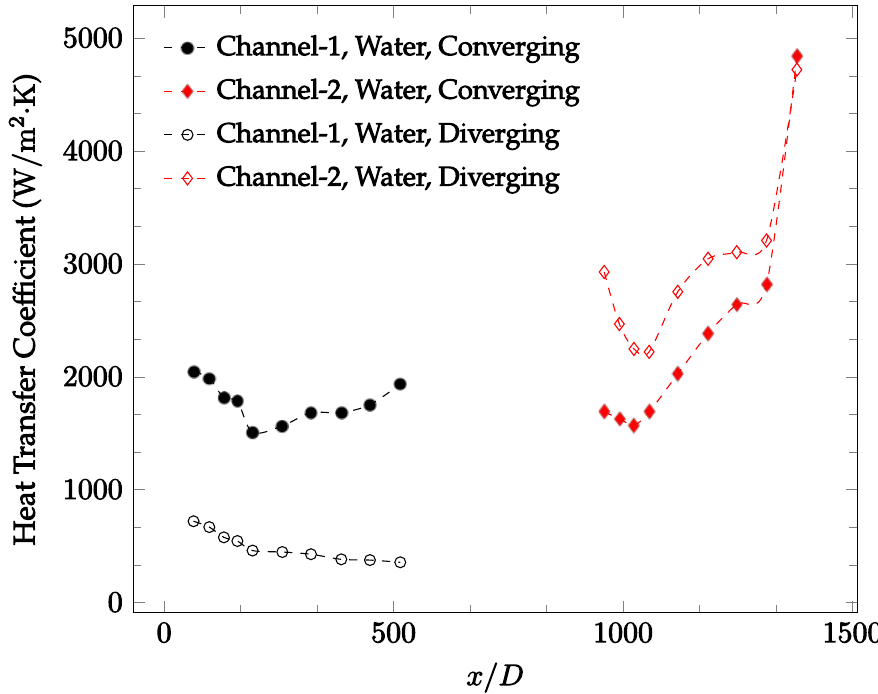
Figure 12. Change in convective heat transfer coefficient of deionized water as a function of dimensionless distance for a Reynolds number of 100. Converging and diverging nozzles are used as connectors.